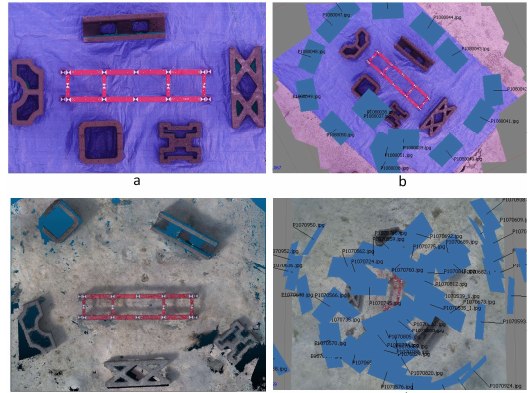
Figure 2. Camera systems calibration settings in air and underwater. (a) 3D point cloud of calibration site in air. (b) Image network in air. (c) 3D point cloud of calibration site underwater. (d) Image network underwater.